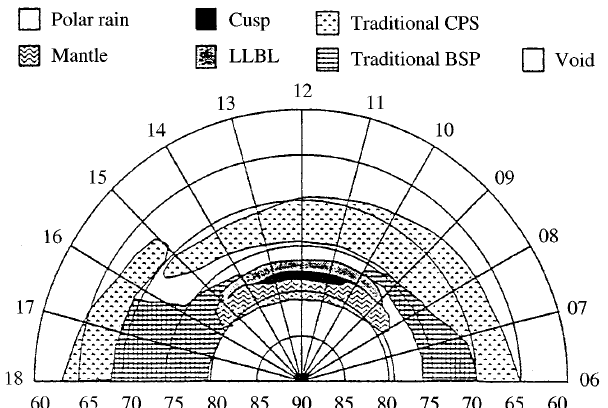
Fig. 1. A map of the high-latitude ionosphere to regions of the magnetosphere based on plasma characteristics (Newell and